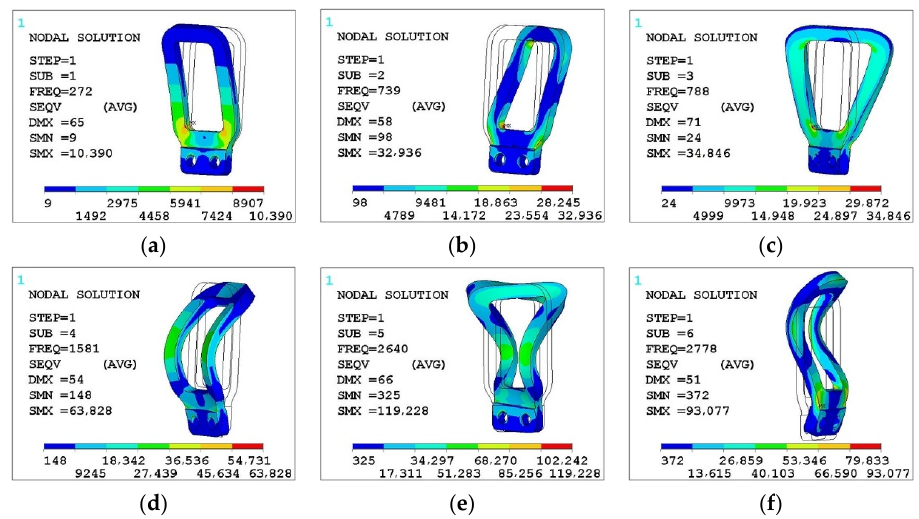
Figure 13. Modal contour plots of the wheelset lifting mechanism: ( a ) 1st modal; ( b ) 2nd modal; ( c ) 3rd modal; ( d ) 4th modal; ( e ) 5th modal; ( f ) 6th modal.